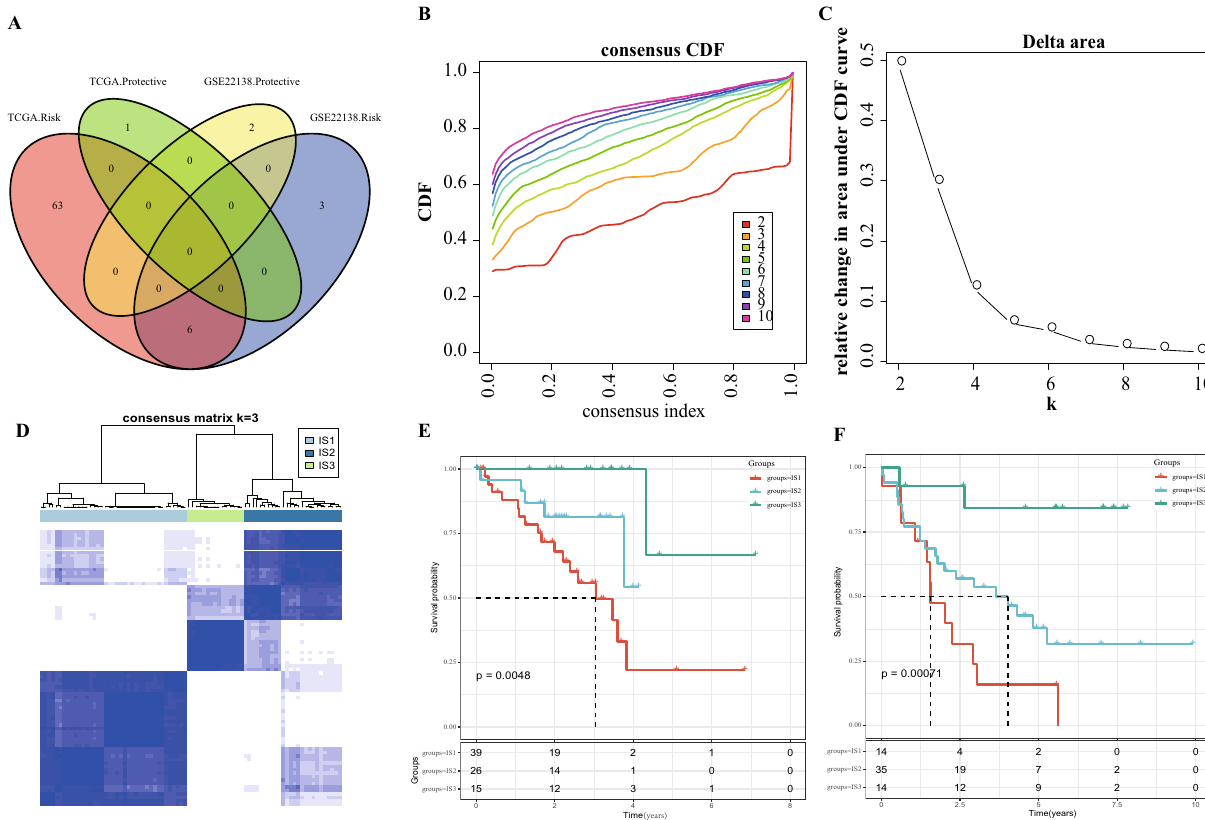
Figure 1. Consensus clustering identified three ISs of UM. ( A ) Venn diagram of intersection of immune cell signature significantly related to OS in patients with UM from TCGA and GSE22138 cohort. ( B ) CDF curves of TCGA cohort samples. ( C ) CDF Delta area curve of TCGA cohort samples (Delta area curve of consensus clustering, indicating the relative change in area under the CDF curve for each category number k compared with k − 1. The horizontal axis represents the category number k and the vertical axis represents the relative change in area under CDF curve). ( D ) The sample clustering heat map at k = 3. ( E , F ) Kaplan–Meier survival curves of patients with different ISs in the GSE22138